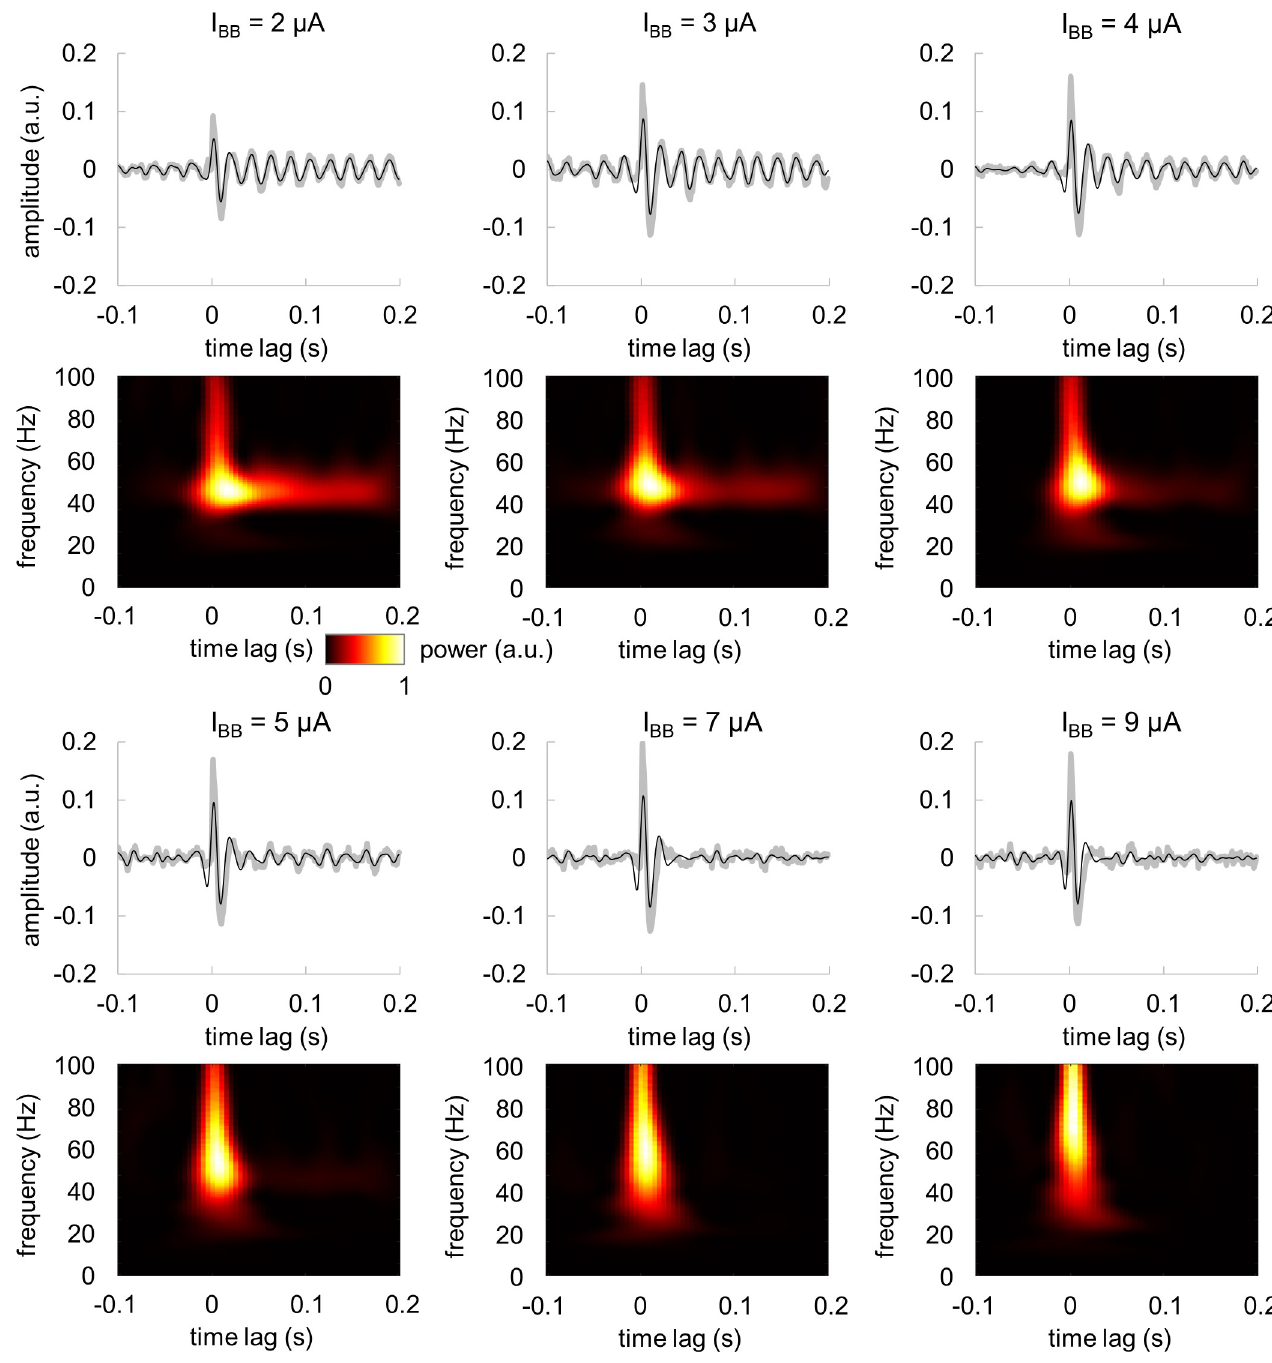
Fig 9. The amplitude of the broadband input current determines temporal characteristics of the gamma echo. TRF ( top panel ) and its time-frequency representation ( bottom panel ). I BB denotes amplitude of the broadband input